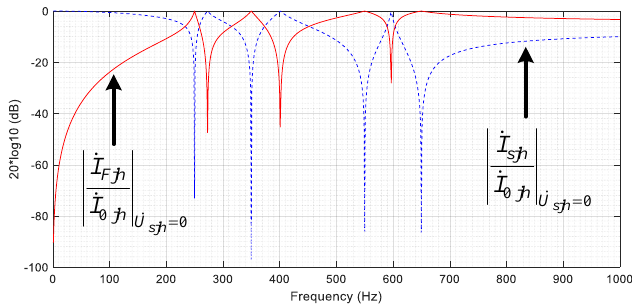
Figure 5. Filtering characteristics of the IF system.